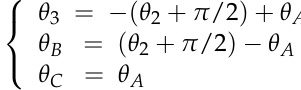
T is obtained by multiply- i T t represented by the translation vector i T r represented by the